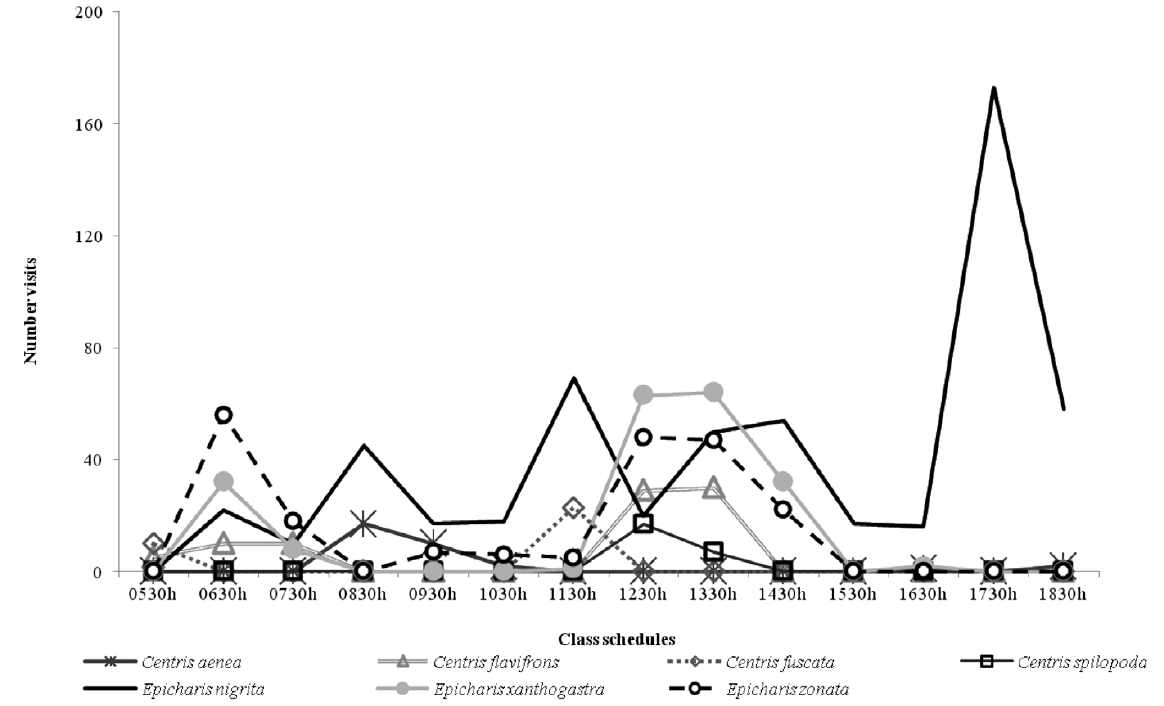
Figure 1 - Number of visits of the pollinators of Byrsonima cydoniifolia at different class schedules, in Pantanal sub-region of Miranda, Mato Grosso do Sul,